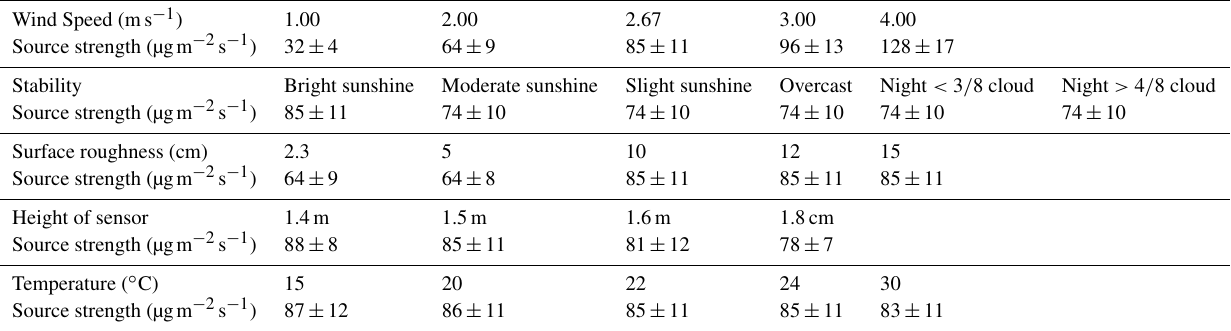
Table 8. Variations in input parameters to WindTrax.